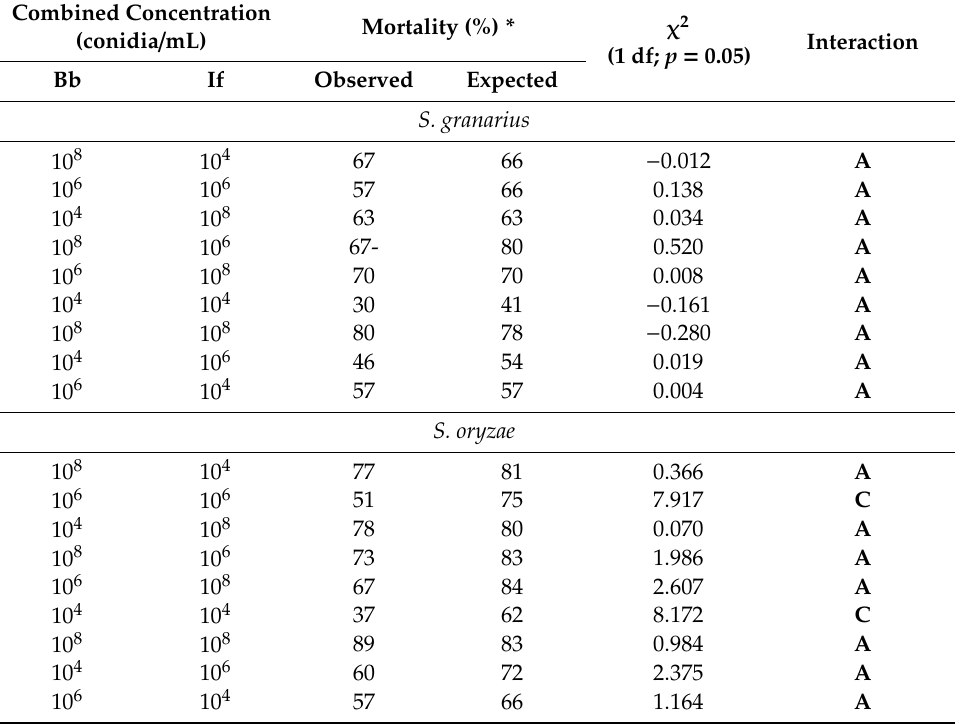
* Expected mortality is calculated according to Robertson and Preisler [40].